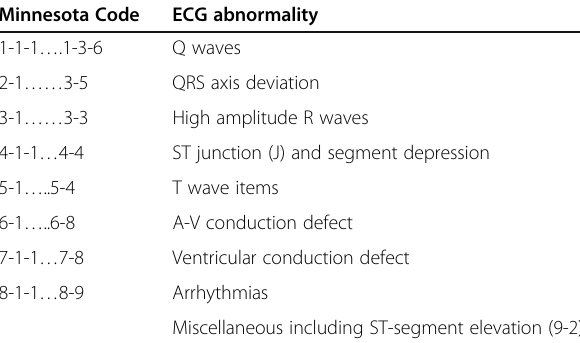
Table 1 An overview of the Minnesota Code Classification System for Electrocardiographic Findings Minnesota